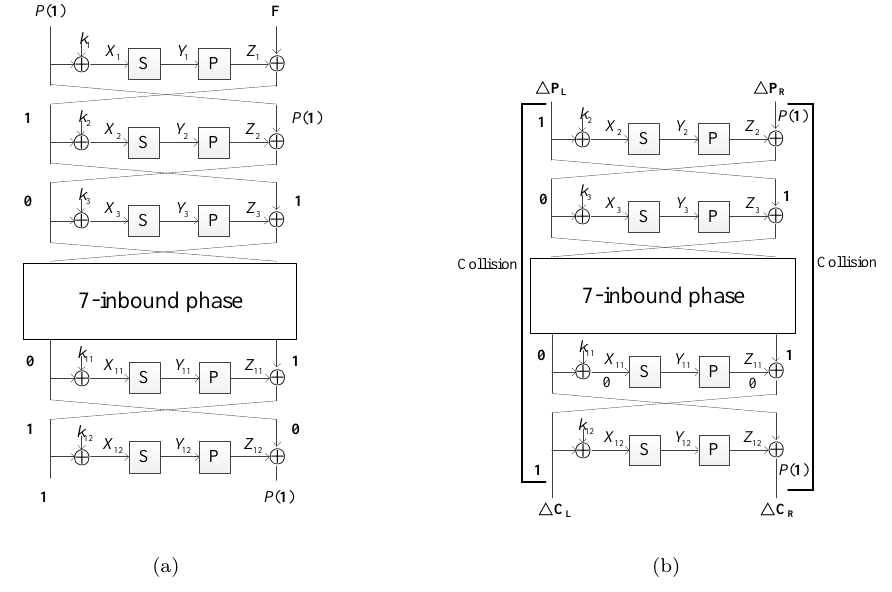
Figure 4: (a) 12-round chosen-key distinguisher, (b) 11-round collsion